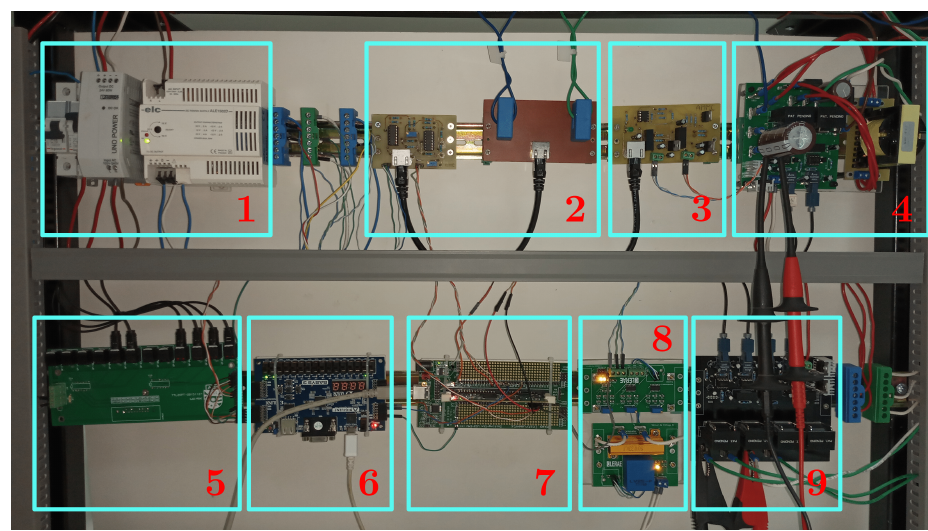
Figure 3. Implementation of the push–pull microinverter.